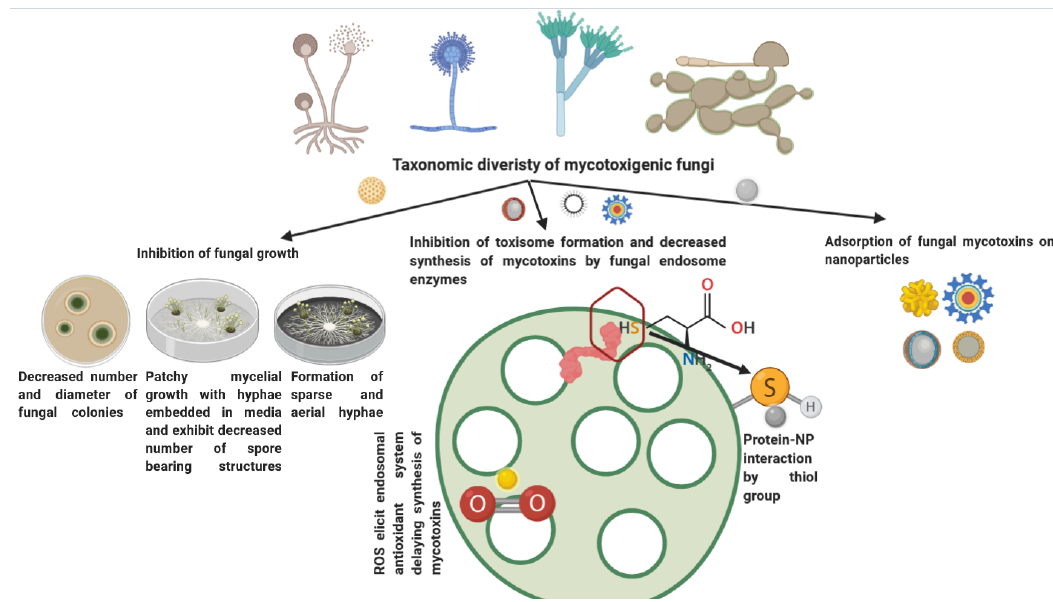
Figure 4. Zinc nanomaterials can exhibit a threefold impact on the production and neutralization of mycotoxins produced by mycotoxigenic fungi.